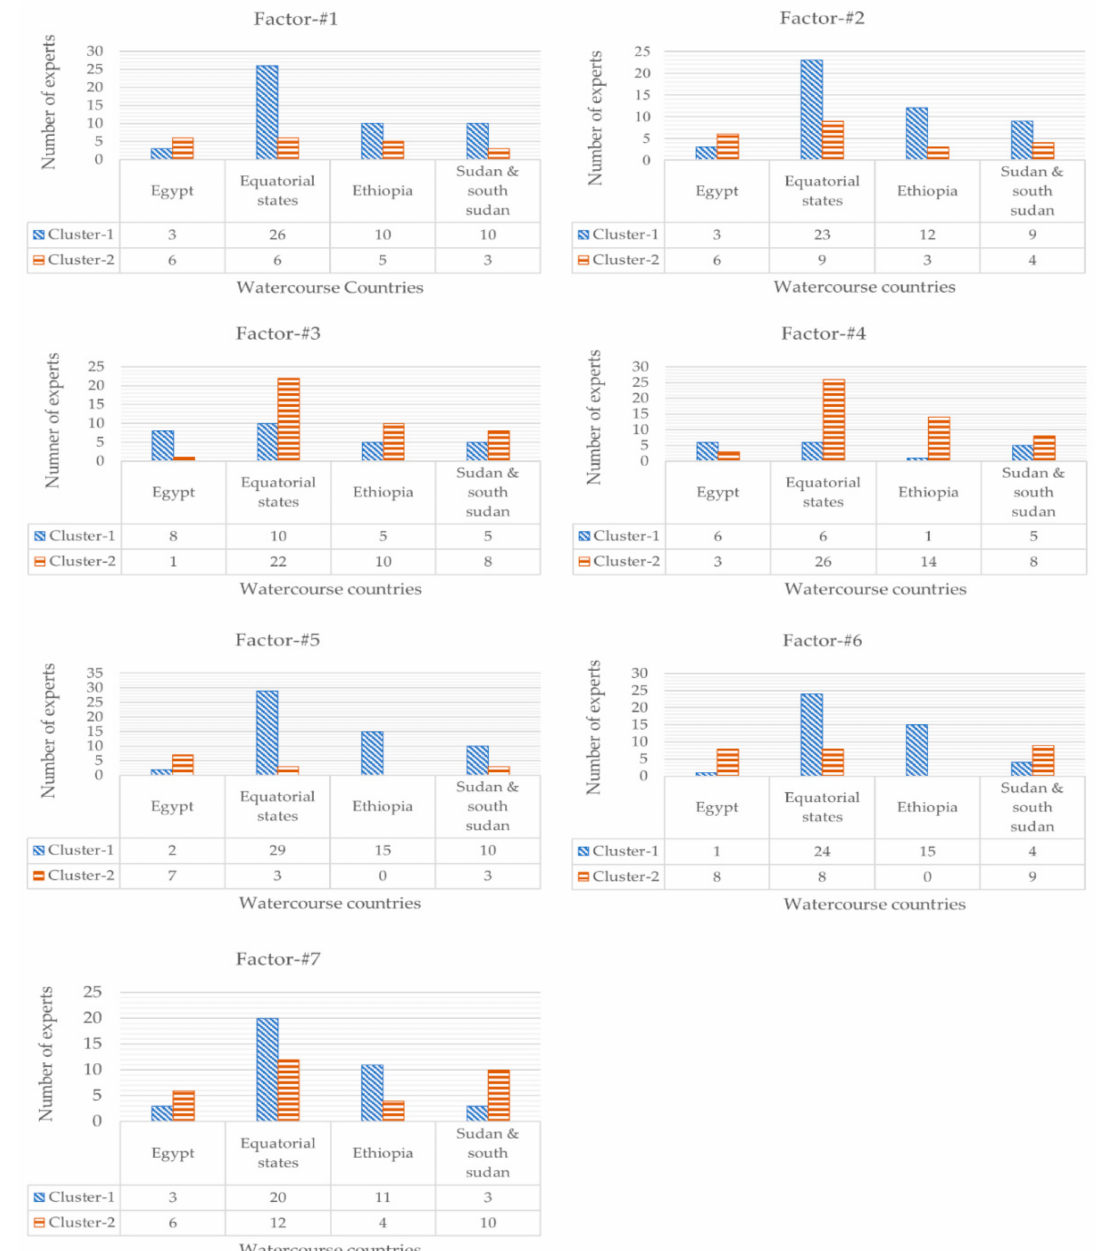
Figure 8. The number of experts from upstream and downstream states in each cluster, organized by factor. Where factor-#1 is geography, hydrology, ecology, and natural features, factor-#2 is socio-economic needs of basin states, factor-#3 is the population dependent on the watercourse, factor-#4 is the e ff ects of water use, factor-#5 is existing and potential uses, factor-#6 is costs of conservation and protection, and factor-#7 is availability of alternative and comparable values and